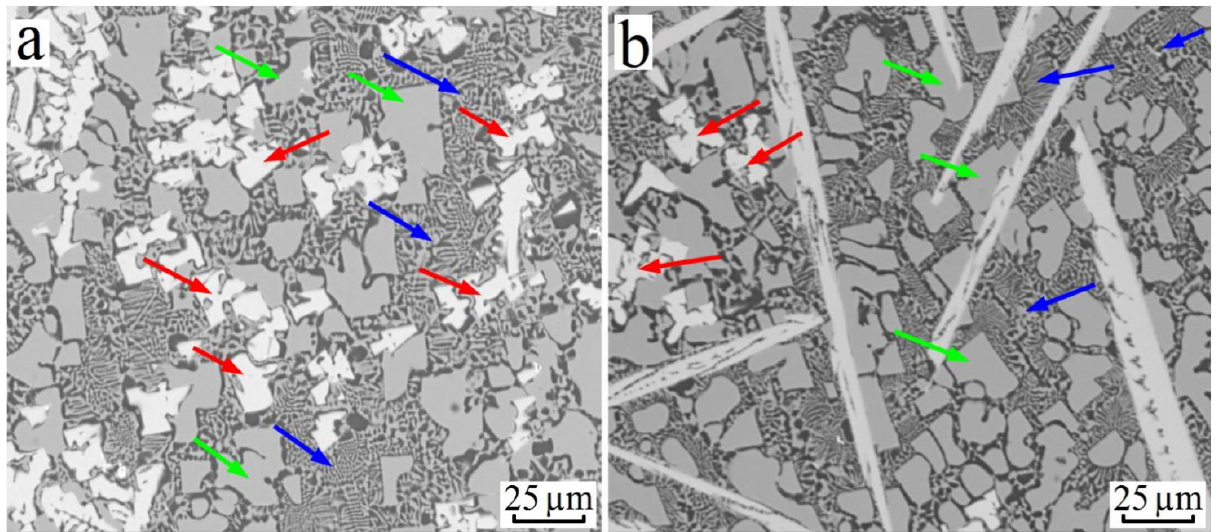
Figure 3. Distribution, sizes and forms of growth of aluminides in alloys: ( a ) Al–31.47Cu–8.63Zr (Z2); ( b ) Al–31.25Cu–8.37Zr (Z4) (magnification × 1000). The arrows point to main structural components of these alloys: the θ -phase Al 2 Cu (green arrows), the α -Al + θ eutectic (blue arrows) and L 1 2 trialuminides (red arrows).